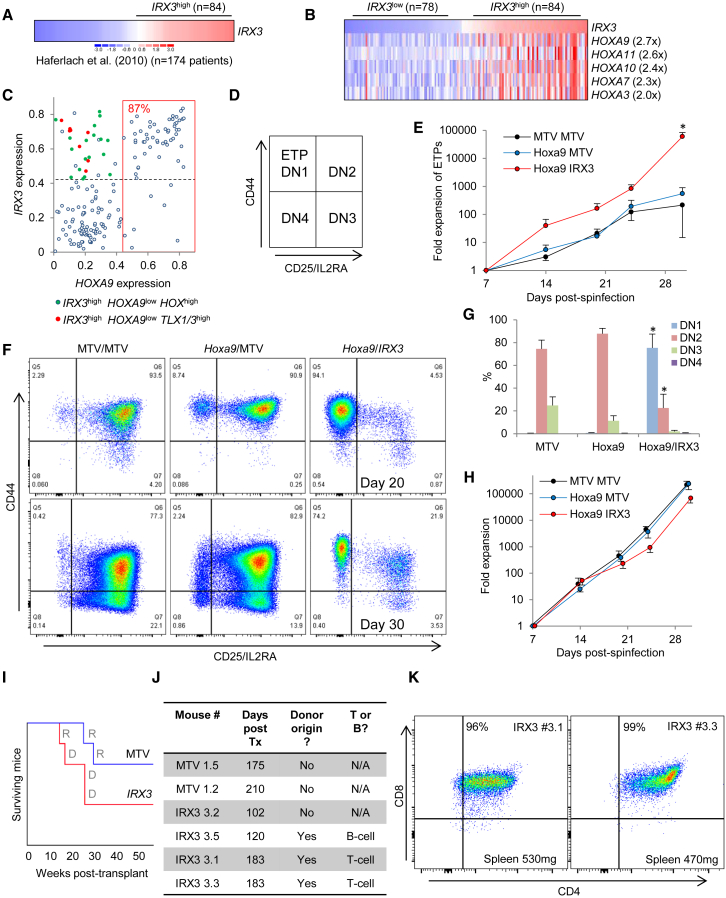
IRX3 Misexpression in Lymphoblastic Leukemia(A) IRX3 expression in bulk human T-ALL samples.(B) Heatmap shows IRX3high versus IRX3low T-ALL cases and the most differentially expressed transcription factor genes with mean fold change.(C) IRX3 versus HOXA9 expression in primary human T-ALL (Haferlach et al., 2010). Percentage in red text indicates the proportion of HOXA9high samples (red box) with high IRX3 expression (above the dotted gray line).(D) Immunophenotypic definition of early T cell progenitor double-negative (DN) populations.(E) Mean + SEM fold expansion in OP9 DL1 stromal culture of ETP/DN1 cells over input number on day 7 (n = 4–6). MTV, empty vector.(F) Representative flow cytometry plots.(G) Immunophenotypic developmental stage of Linneg BM HSPCs expressing the indicated gene combinations cultured for 30 days on OP9 DL1 stroma (mean + SEM percentage, n = 6).(H) Mean + SEM fold expansion in OP9 DL1 stromal culture of total cell number over input numbers on day 7 (n = 4–6). For (G) and (H), ∗p ≤ 0.05 using one-way ANOVA with Fisher’s least significant difference post hoc analysis for Hoxa9/IRX3 versus Hoxa9 and MTV conditions.Murine CD45.1+ KIT+ BM cells were infected with IRX3-expressing or control retroviral vectors, and 96 hr later, 106 drug-resistant cells were transplanted into irradiated CD45.2+ congenic recipients.(I) Survival curves. D, donor-derived leukemia; R, recipient-derived leukemia.(J) Survival times and cause of death.(K) Flow cytometry plots show immunophenotype of CD45.1+ BM cells at death in the indicated mice.See also Figures S6 and S7.